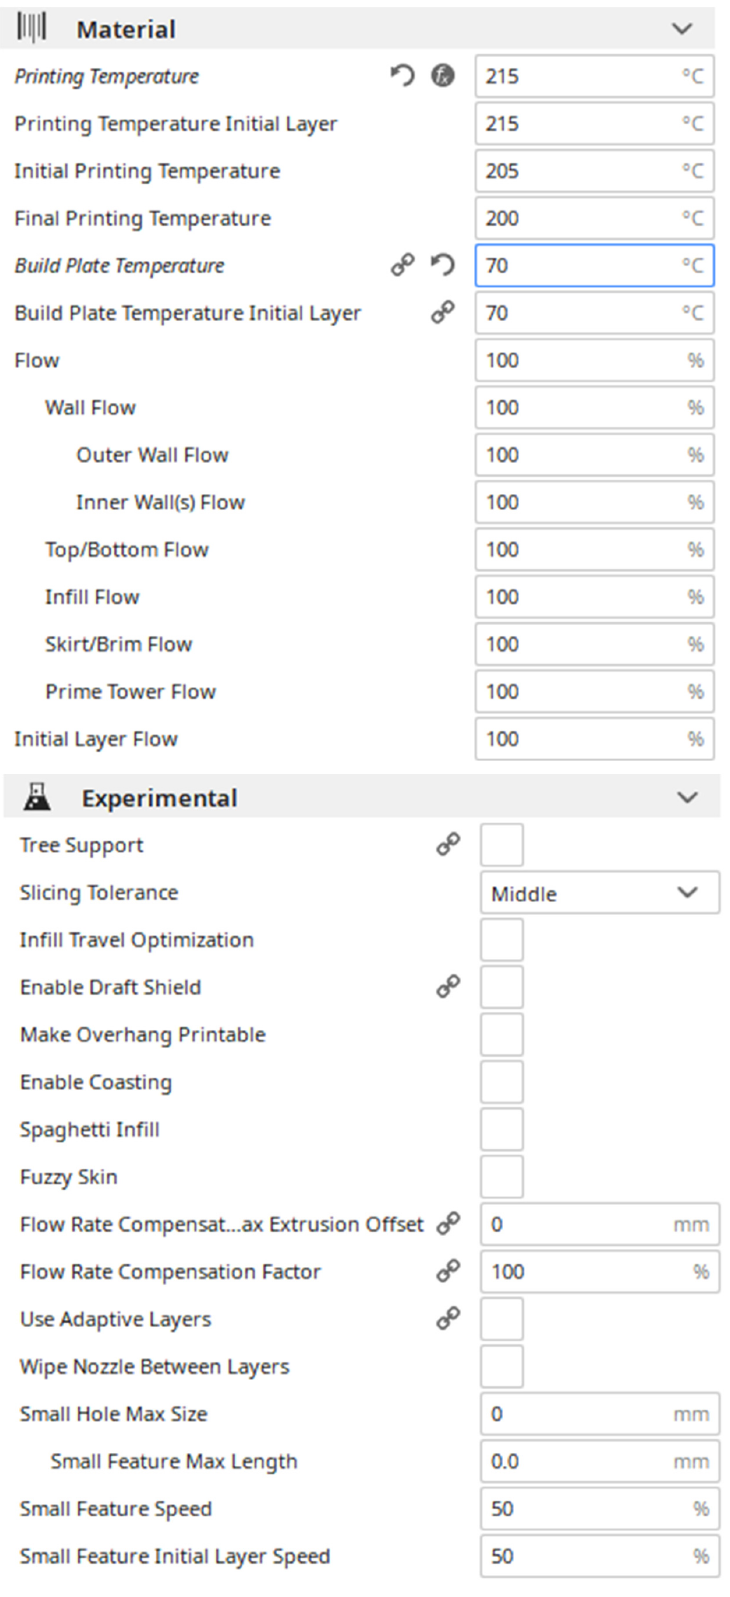
Figure 7. Configuration parameters in the Ultimaker Cura ® software for manufacturing the frame of the spectacles using polylactic acid (PLA) as the material.